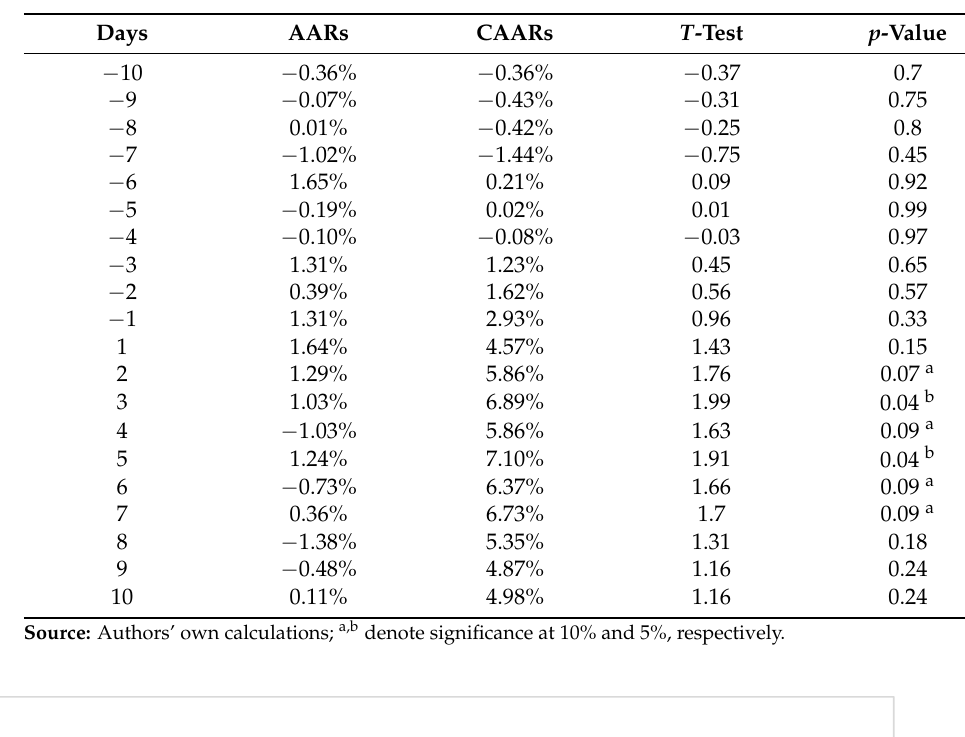
Table 3. Cross-border acquisitions in the US and UK.